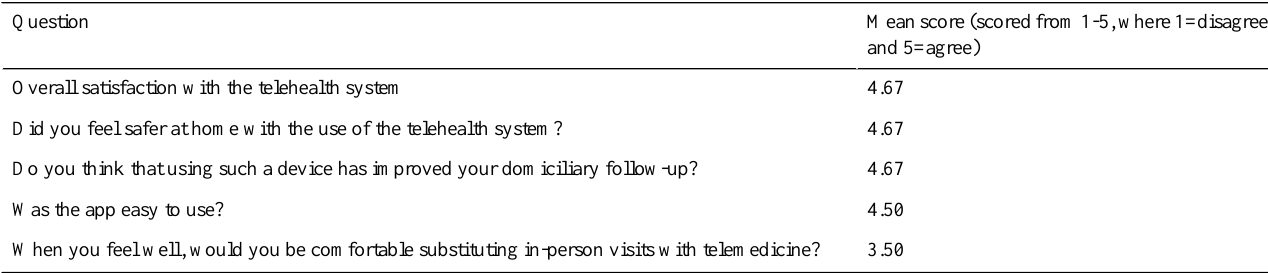
Table 1. Patients’responses to survey questions about their experience with the telehealth system (n=12).